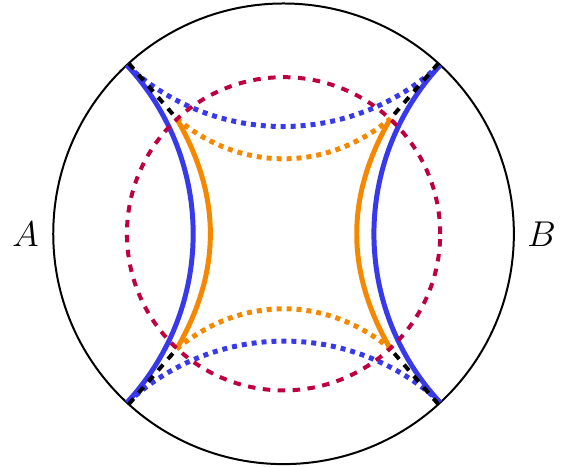
Figure 2 . Two di(cid:11)erent candidate extremal surfaces for boundary region A [ B in vacuum AdS 3 , both in the \boundary-anchored" cuto(cid:11) prescription and the \cuto(cid:11)-anchored" cuto(cid:11) prescription. The \disconnected" candidates are shown as solid curves, while the \connected" candidates are shown as dotted curves. In this instance, it is clear that the \dotted" surfaces and \solid" surfaces should be identi(cid:12)ed with one another; to make this precise in general, one must use the language of extremal foliations (cf. (cid:12)gure